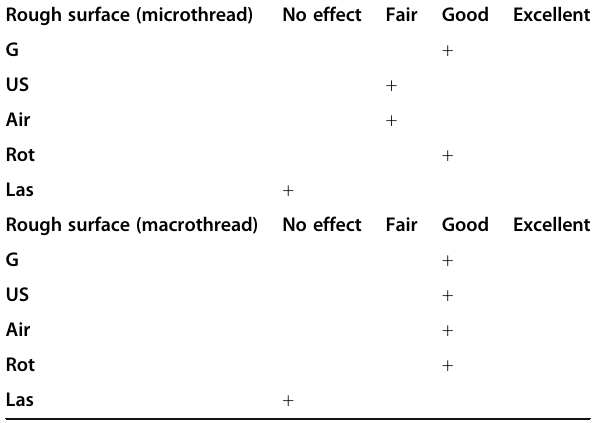
Table 1 Qualitative evaluation by SEM analysis of micro- and macrothread areas of rough surface implants Rough surface (microthread)